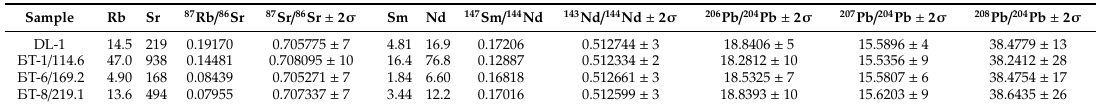
Table 2. Sr–Nd–Pb isotope data for Turumakit intrusions (element contents in ppm, uncertainties correspond to the last digits of respective ratios).